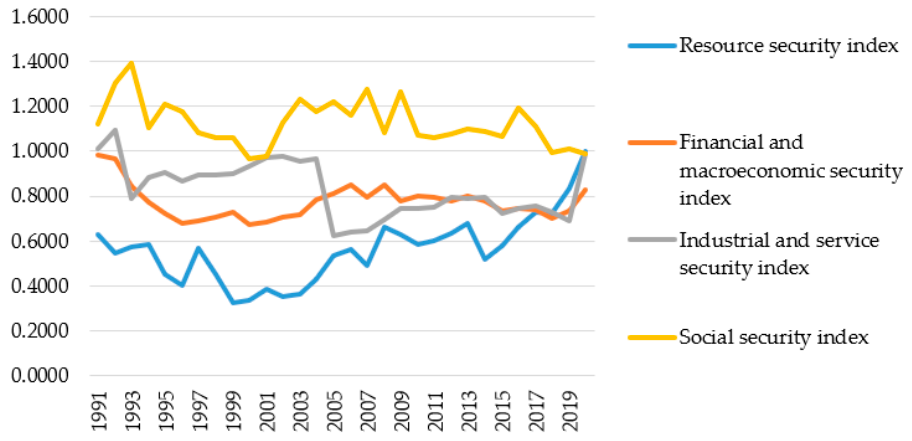
Figure 11. Comparative dynamics of economic security indices of Ukraine, Germany, France, and Poland during 1991–2020.